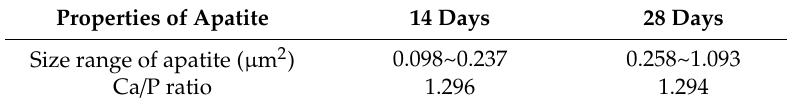
Table 3. Apatite sizes and Ca / P ratio at post-immersion in simulated body fluid (SBF).